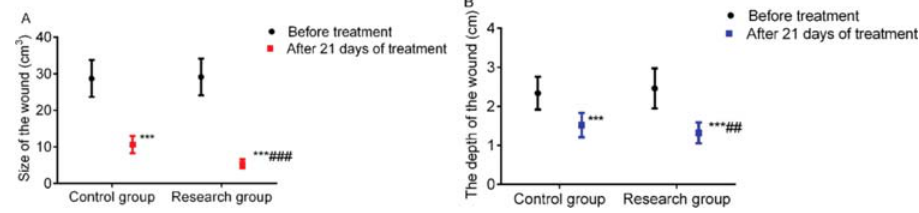
Figure 2 - Comparison of wound size and depth between the two groups. A: Wound size, B: Wound depth. *** indicates p o 0.001 when compared to levels before treatment; ### indicates p o 0.001 when compared to the control